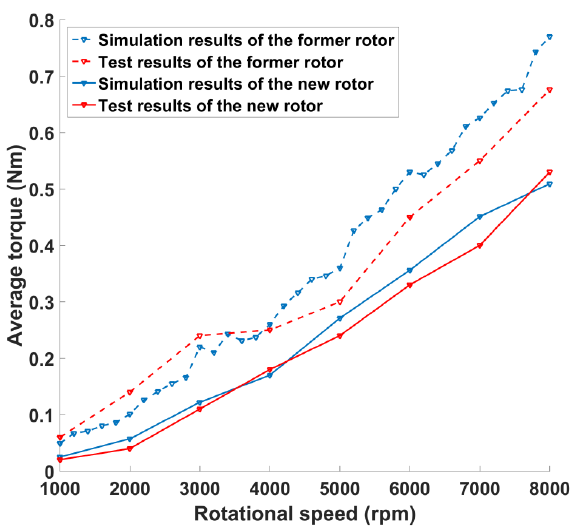
Figure 13. The churning loss torques of the new rotor and the former rotor.